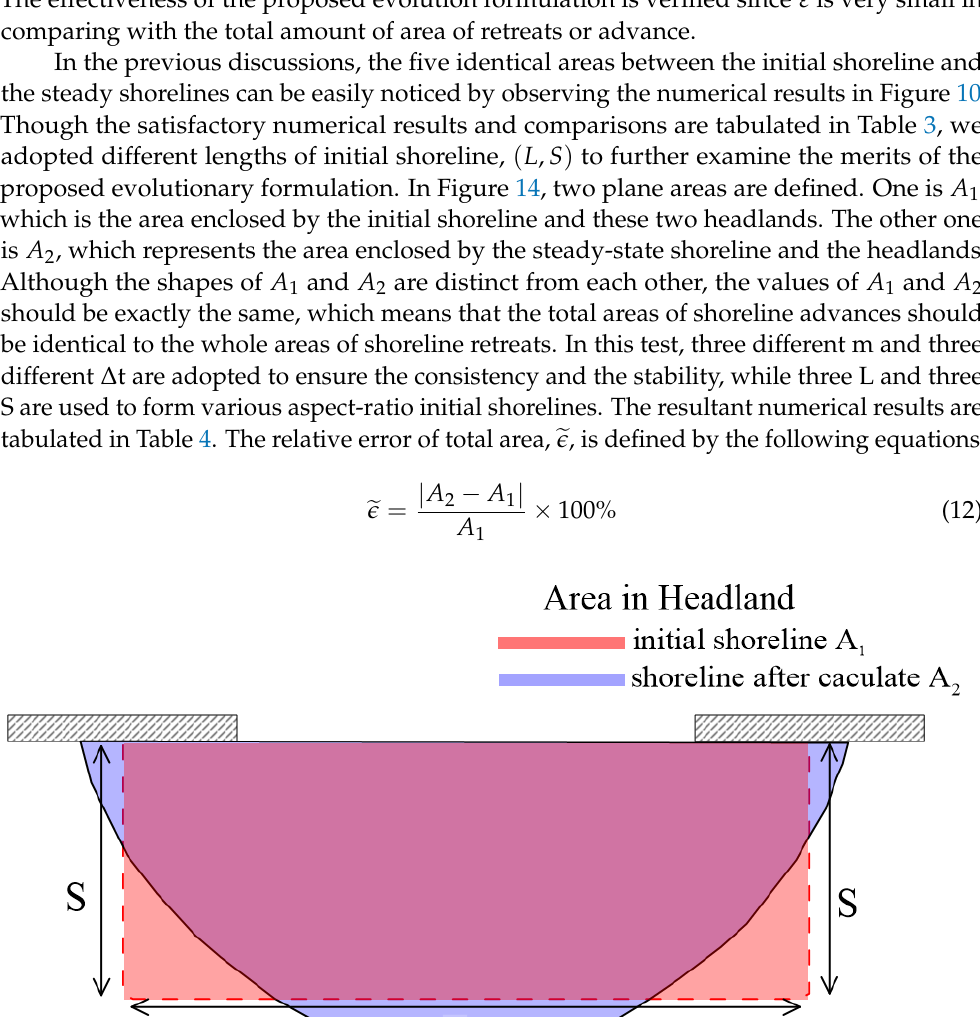
and , which are enclosed by shorelines and 𝐴𝐴 1 𝐴𝐴 2